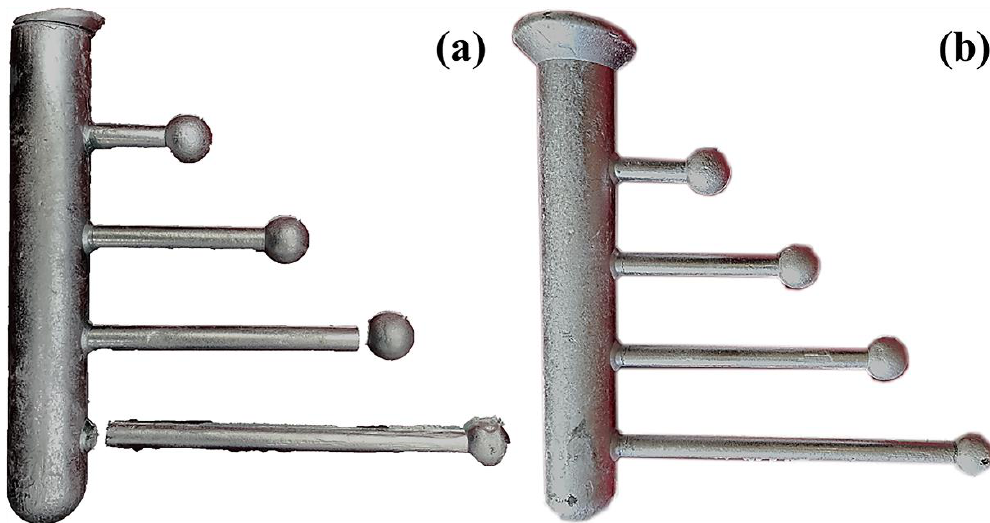
Figure 5. Hot tearing performance samples under treatment with or without the addition of Sc element: ( a ) No Sc; ( b ) 0.15% Sc.